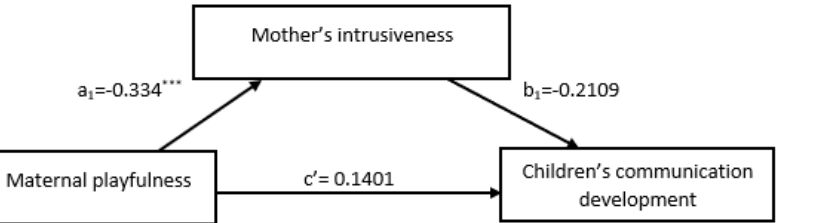
Figure 2. Effect of maternal playfulness on children’s communication development mediated by mothers’ intrusiveness. Asterisks (***) indicate the significance effect of maternal playfulness on mother’s intrusiveness ( p < 0.001) (a1).